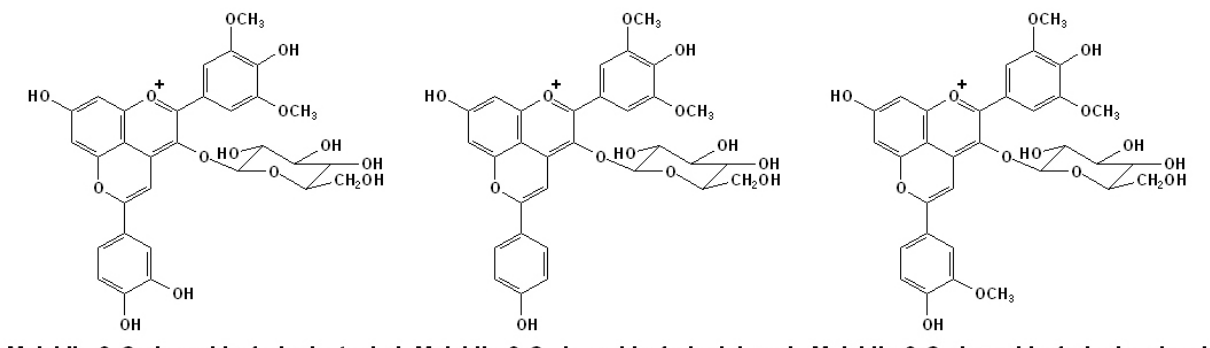
Figure 3. The structures of hydroxyphenyl-pyranoanthocyanins generated from malvidin- 3- O -glucoside